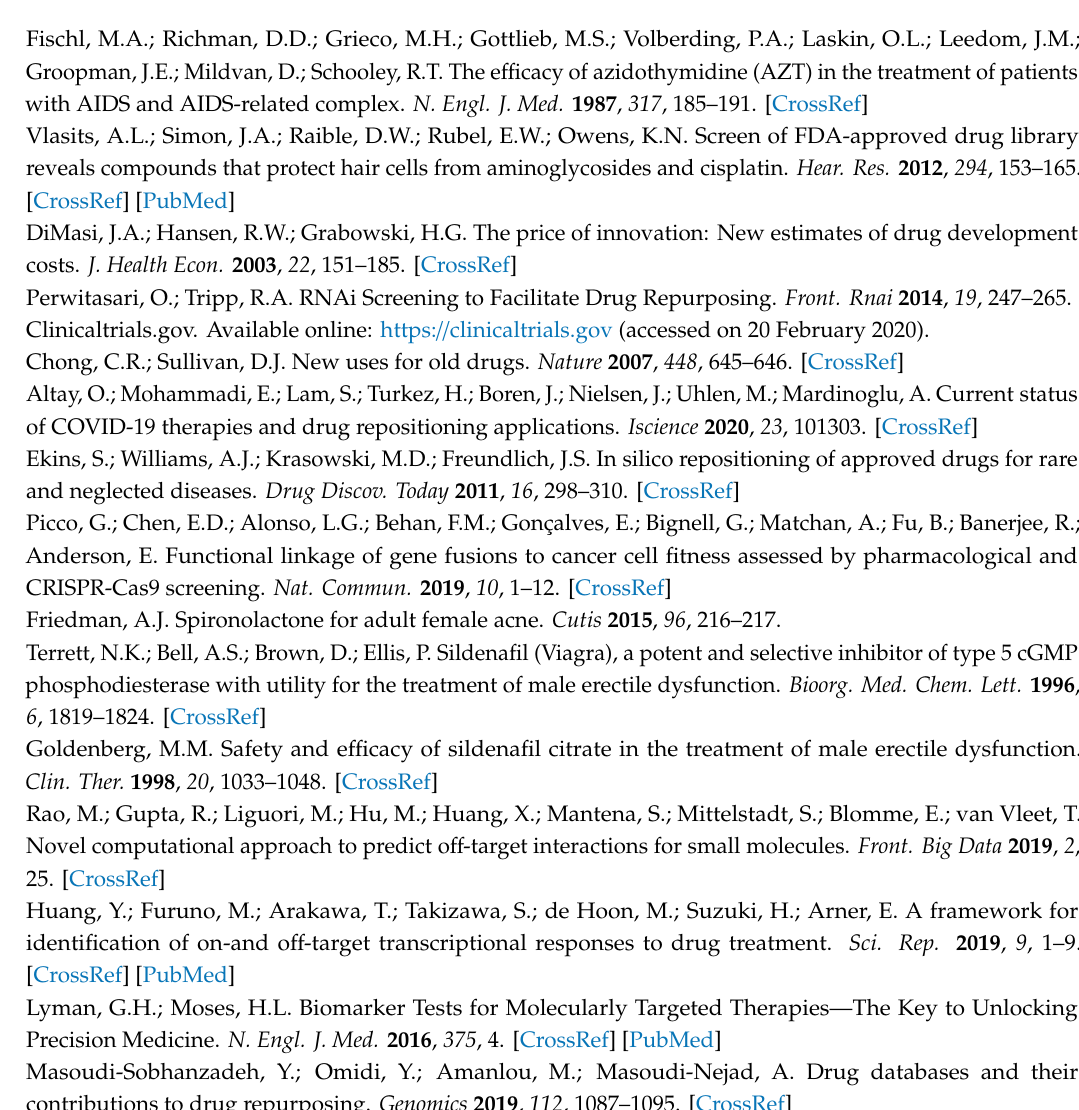
Table S1: An overview of all DBs discussed in this review in terms of the type of assay(s), data, and availability of